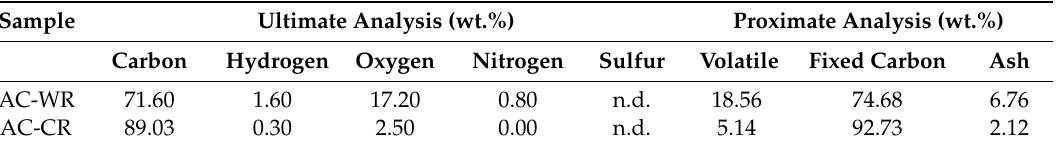
Table 1. Ultimate and proximate analysis of ACs (activated carbons) as precursors. AC-WR: the commercial ACs based on wood material, AC-CR: the commercial ACs based on coconut material, n.d.: not